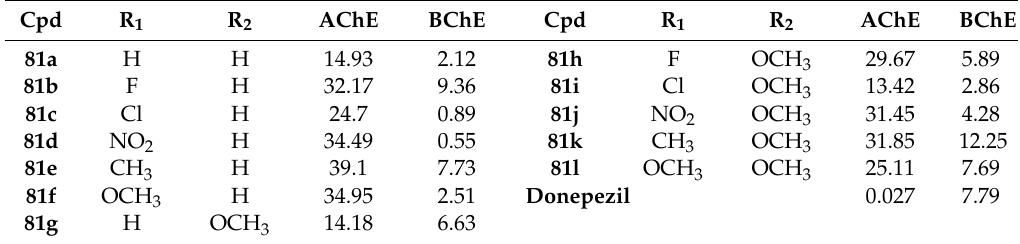
Table 12. Cholinesterace inhibitory activity IC 50 ( µ M) of compounds 81a–l